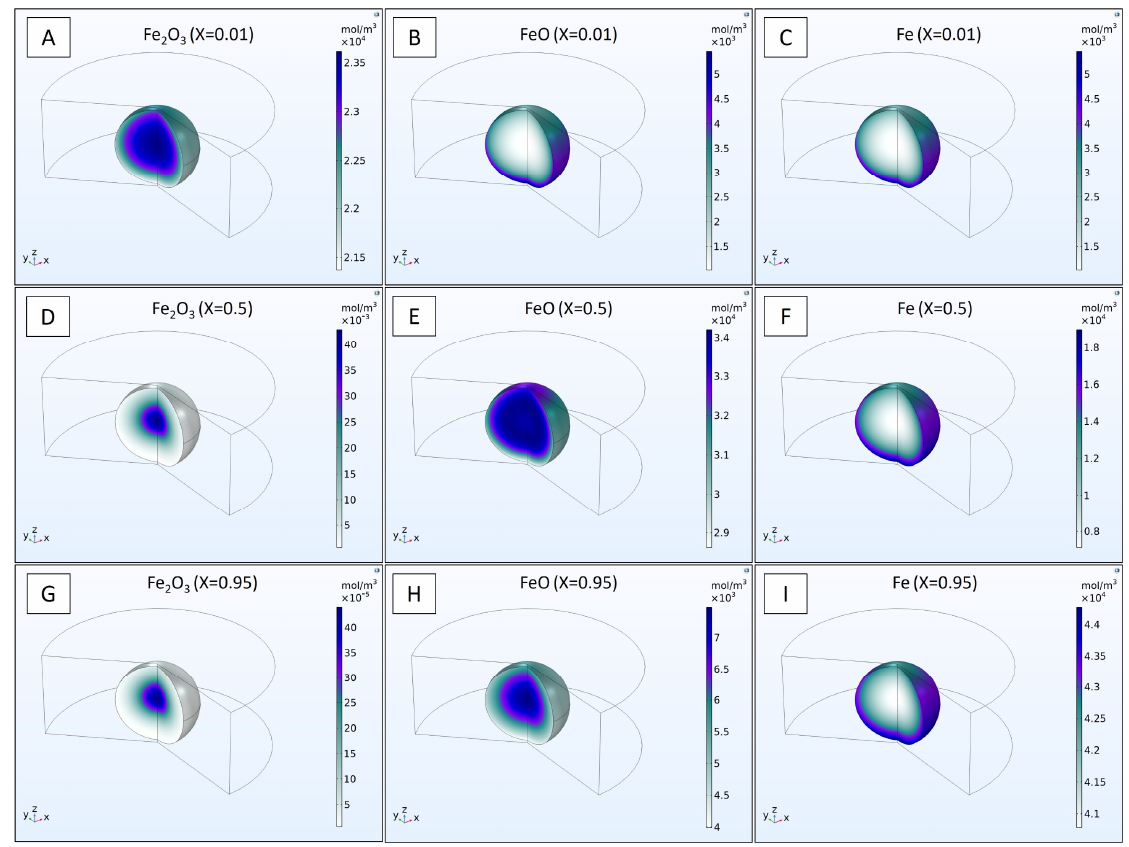
Figure 14. 3D concentration profiles of ( A , D , G ) Fe 2 O 3 , ( B , E , H ) FeO and ( C , F , I ) Fe at X = 0.01, 0.5 and 0.95 respectively (Experiment 3).